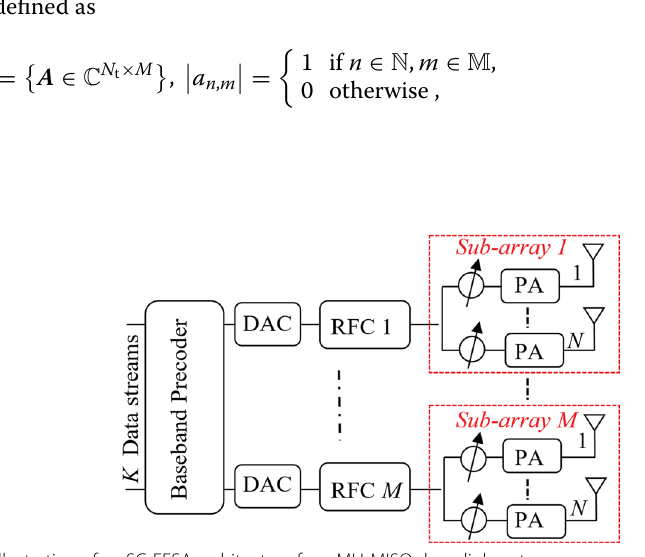
Fig. 1 Illustration of an SC-FESA architecture for a MU-MISO downlink